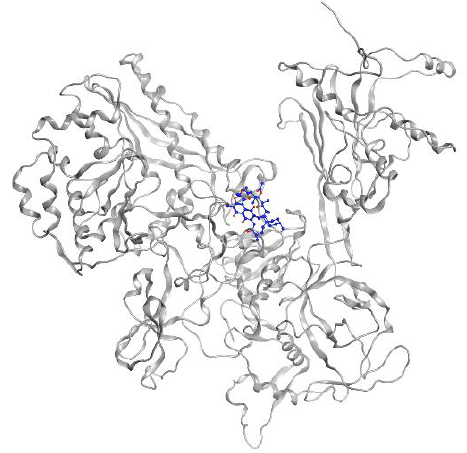
Figure 3. Rifampicin (blue) in MTB RNA polymerase subunit β ( gray ribbon) (PDBID: 5UH6) .